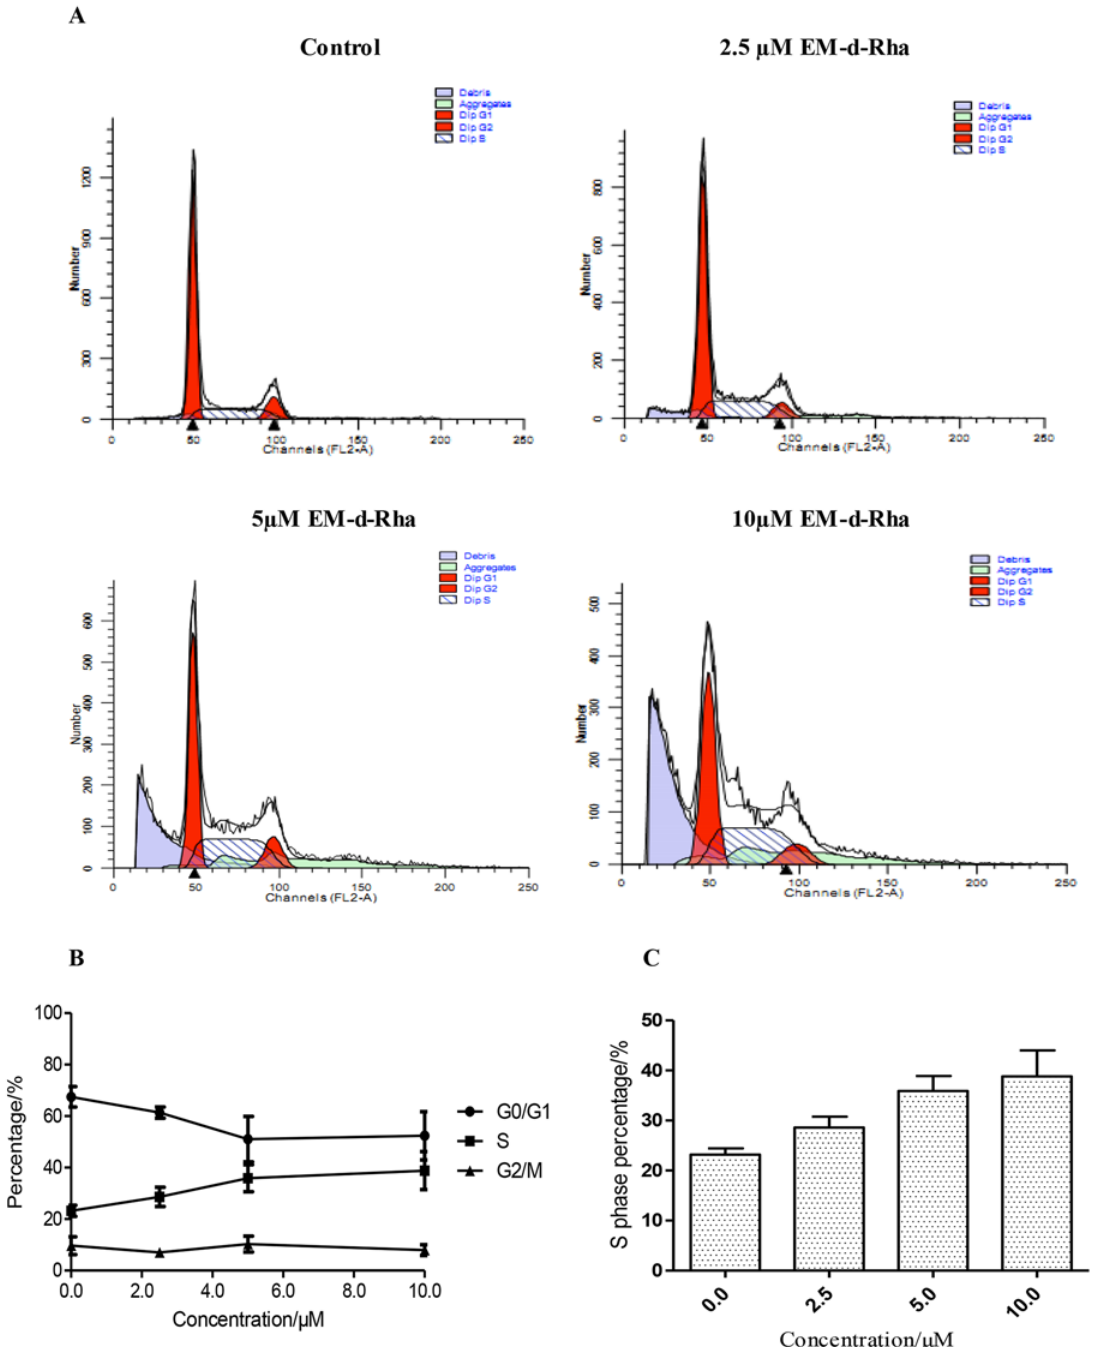
Fig 9. Effects of EM-d-Rha on HepG2 cell cycle distribution in vitro . After HepG2 cell exposure to 0 μ M, 2.5 μ M, 5.0 μ M and 10 μ M EM-d-Rha for 48h, cells were harvested and stained by propidium iodide, then cell cycle distribution was examined by FACS flow cytometric analysis (A). Data pooled from three independent experiments show the percentage of cell cycle distribution of HepG2 cells (B). The percentage of S phase over total cells was calculated and expressed on each histogram (C).The error bars represent mean ± standard deviation (B and C). Difference was considered statistically significant when * p < 0.05 vs . control